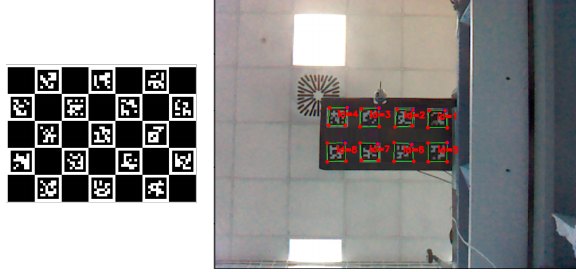
Figure 8. ( Left ) Sample ArUco Markers. ( Right ) Corner extraction in subpixel accuracy from ArUco